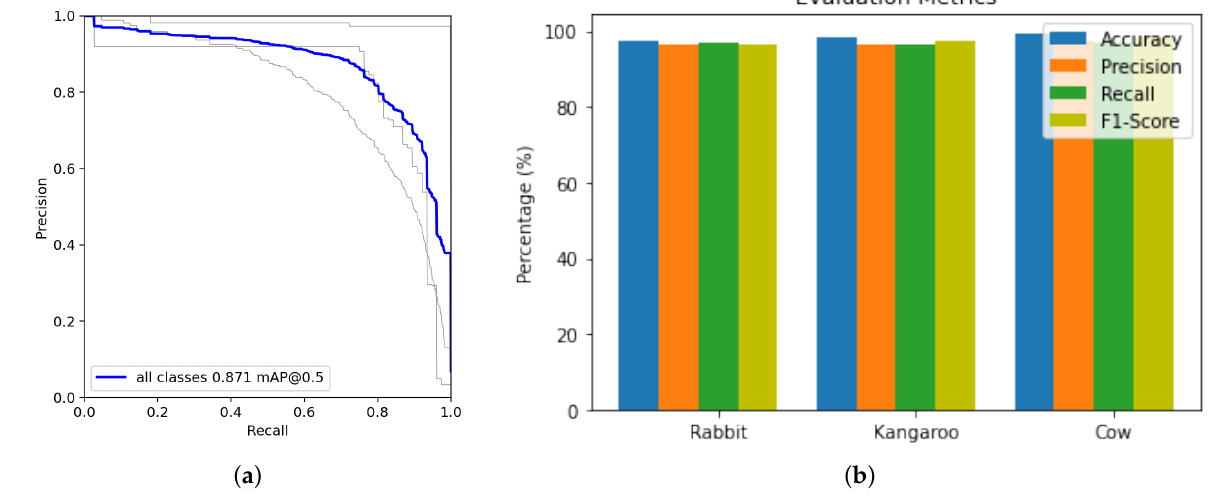
Figure 8. ( a ) Mean Average Precision (mAP) for all the classes. ( b ) System performance metrics for each class of